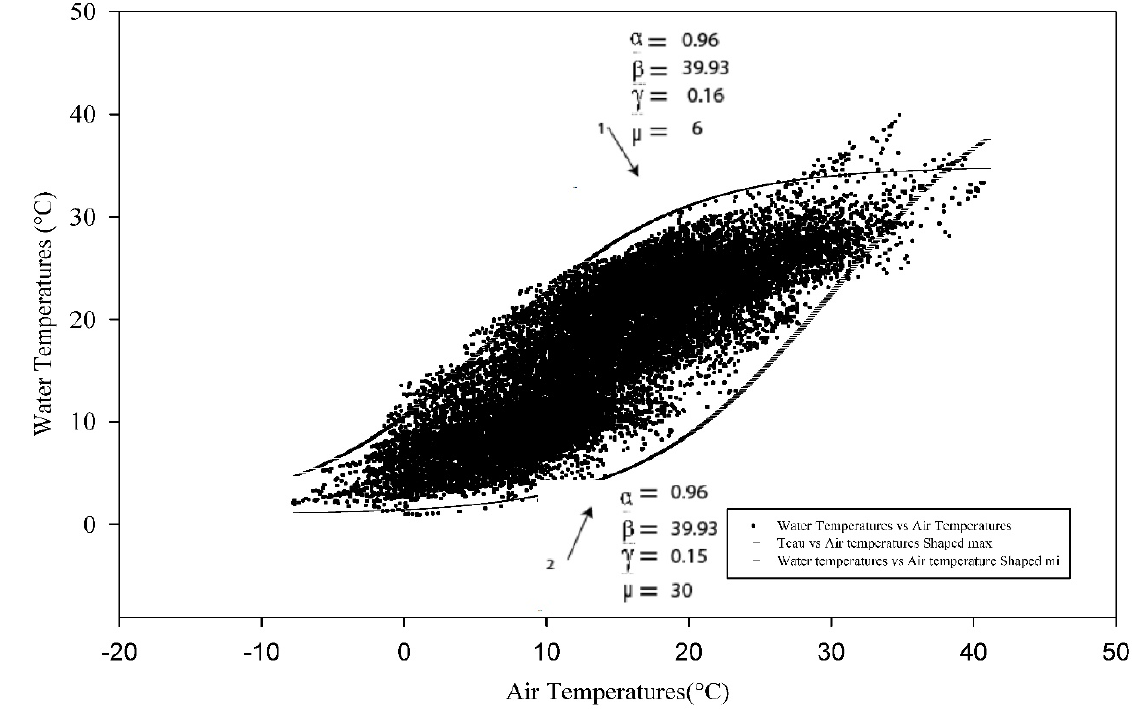
Figure 5. Adjustment of hourly (min and max) water temperatures as a function of air temperatures recorded at the Berger station in 2018.